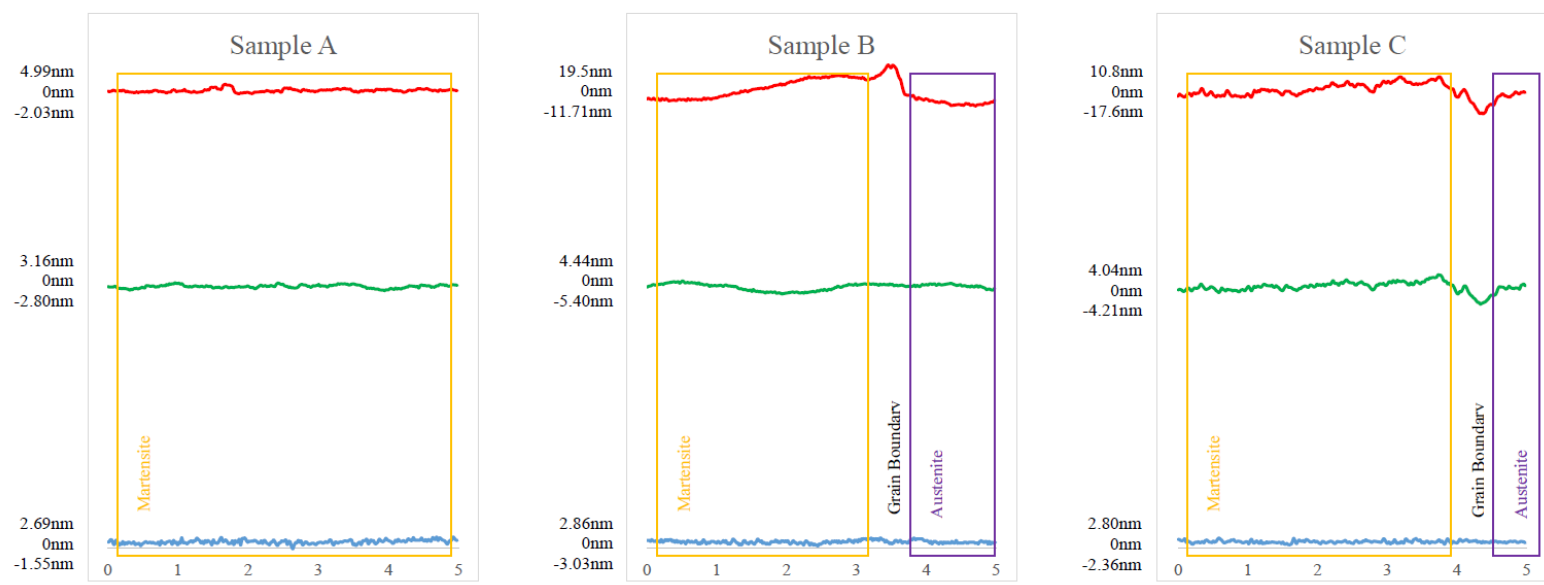
Figure 3. Displays of line scan profiles acquired from AFM results, with separation distance between each line to prevent overlapping—0 min (blue), 60 min (green), and 105 min (red); labelled of microstructure region: martensite (yellow), grain boundary (black), and austenite (purple).